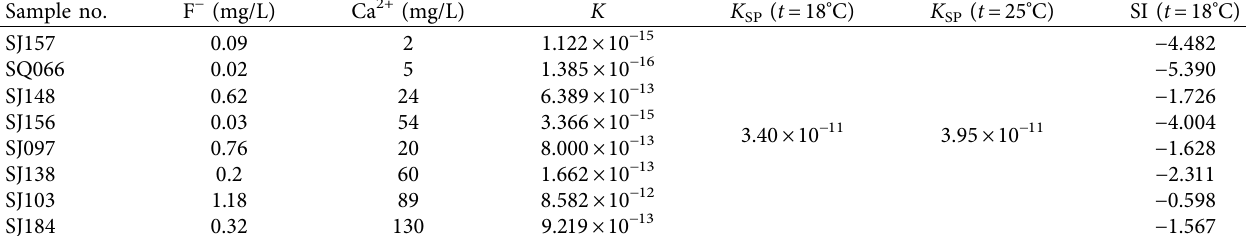
Table 4: Equilibrium constant ( K ), solubility product constant ( K Sample no.